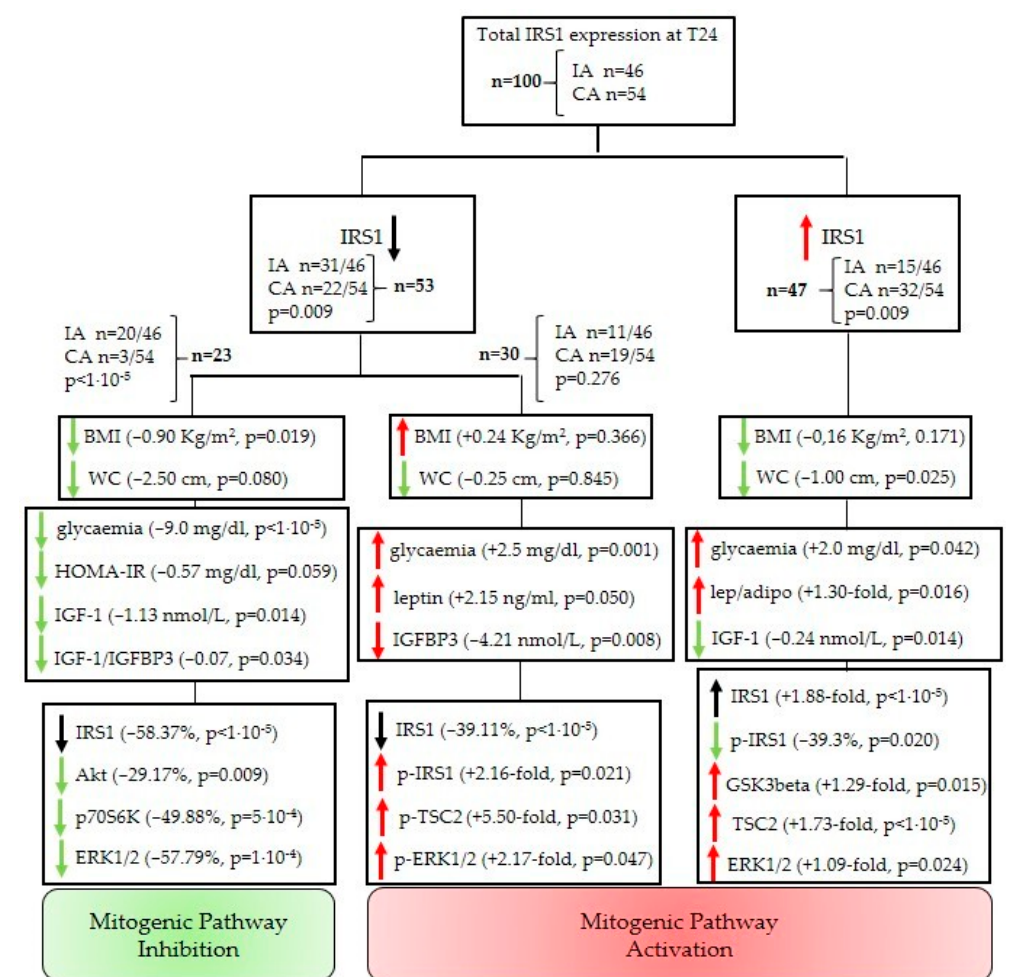
Figure 5. Identification of different patient subpopulations based on the modulation of IRS1 expression after 24 months from the start of the intervention program. Patients were divided on the basis of the downregulation (lower) or upregulation (higher) of IRS1 expression at the end of the intervention program compared to the basal expression at the time of enrollment. Within the lower IRS1 subpopulation, patients who had improved glycaemic control and patients who had unchanged or worsened glycaemic control were analyzed separately. For each group of patients, data regarding anthropometric parameters, serum analytes, total expression, and the relative phosphorylation level of proteins extracted from Barrett’s lesion were reported. Data indicate the median variation (T24 − T0) of the parameter considered, followed by a p -value (the Wilcoxon matched-pairs signed-rank test was used to compare measurements at T0 and T24 within the same group). A reduction in protein levels was indicated as the median of the variation expressed as a percentage (%). An increase in protein level was indicated as n-fold of the amount detected at baseline. Parameters not included in this diagram were not significantly modified. 1 The Fisher’s exact test was performed to assess differences between the proportions of patients belonging to the two arms within each subpopulation identified. The up/down arrow indicates an increase/decrease in the parameter’s measure at 24 months compared to baseline. The green arrow indicates a positive change (protective against cancer evolution) in the parameter considered. The red arrow indicates a negative change (procancer) in the parameter considered.